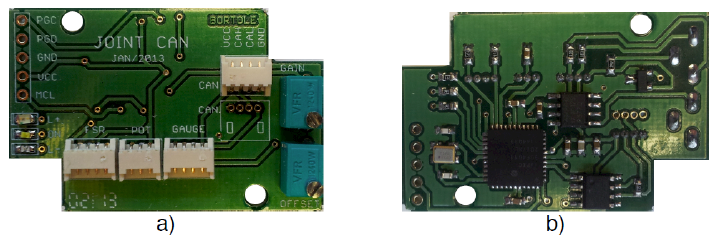
Figure 4. Custom-made boards for the acquisition and transmission of sensor data. ( a ): Top side and ( b ): Bottom side of the boards.